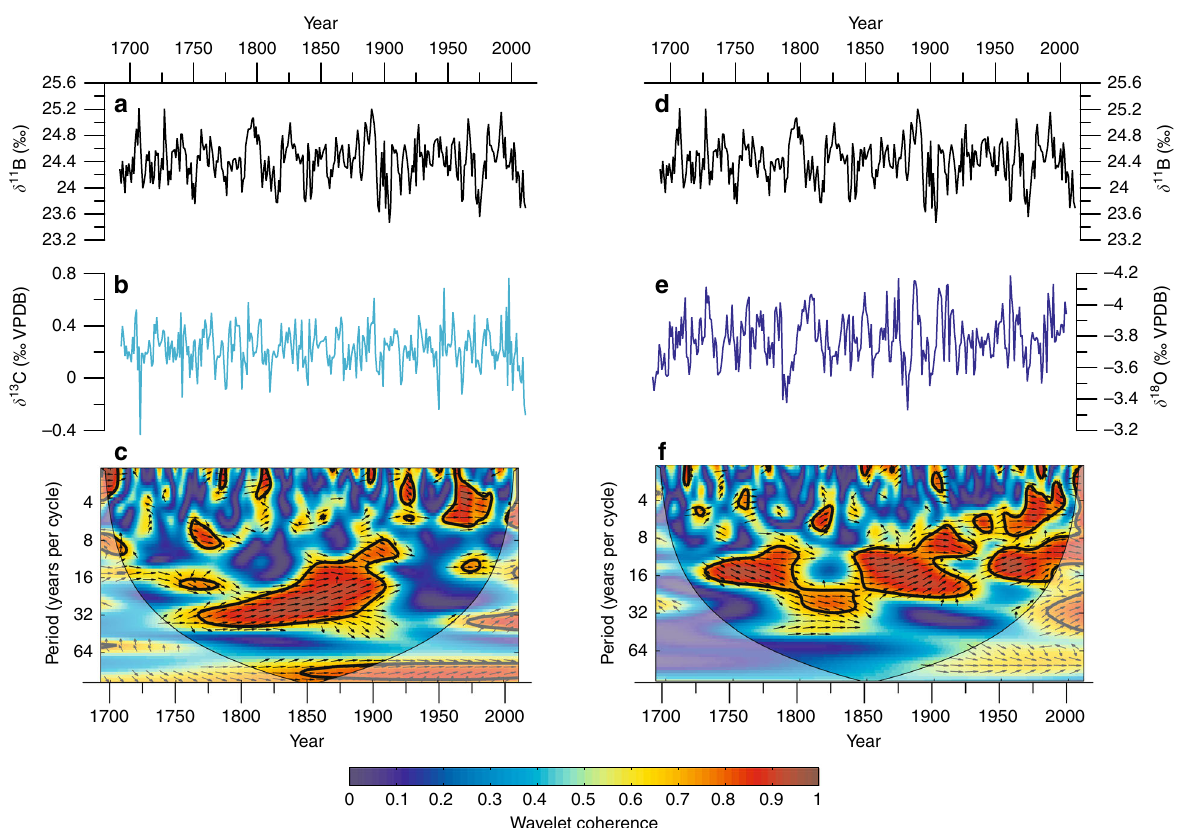
Fig. 7 Cross-wavelet results of proxy variability in the South Paci fi c. a The coral δ 11 B (secular trend removed; trend shown in Fig. 2) compared with b δ 13 C with c cross-wavelet coherence analysis between the two time series with black contour lines enclosing time-periodicity regions with signi fi cant concentrations of coherence. Arrows to the right indicate positive coherence. d Coral δ 11 B compared with e δ 18 O with f cross-wavelet coherence results indicating a signi fi cant shift in periodicity concentration from the earlier part of the record with longer-term decadal-interdecadal variability to the most recent years that are dominated by interannual The micro-sampling strategy is similar to the methods used in many coral- based palaeoceanography studies and for this coral genus with a slow milling procedure to minimise sample fl aking 31 . Milling was completed with a Proxxon mill for coral powder collection at predetermined annual sampling intervals based on the X-radiographs (Supplementary Fig. 4). The sampling transect on the coral slab remained predominantly on a single coral polyp (1cm in diameter) where possible (Supplementary Fig. 2). The distance for annual sampling was based on density banding (ca. 3mm) with a width ca. 1cm that corresponds to one polyp and contains a homogenised mixture of septal and columellar skeletal materials.